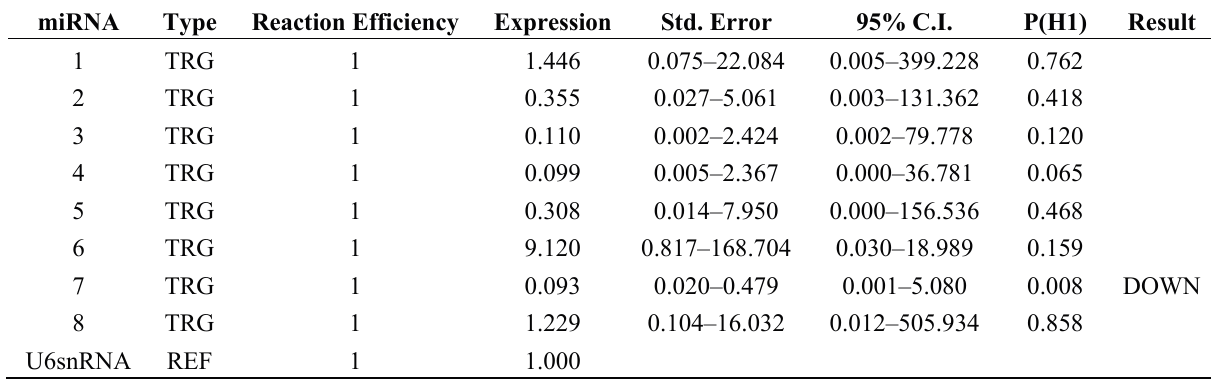
Figure 2. Relative expression (concentration) of the miRNAs analyzed in this study in samples collected in 2010 and frozen at − 80 °C compared with fresh samples. 1 = miR-125b-5p; 2 = miR-425-5p; 3 = miR-200b-5p; 4 = miR-200c-3p; 5 = miR-579-3p; 6 = miR-212-3p; 7 = miR-126-3p; 8 = miR-21-5p. Table 3. Relative expression (concentration), standard error, 95% confidence interval (C.I.), and p -value of miRNAs analyzed in this study (samples collected in 2009 and stored at − 80 °C compared with fresh samples). miRNA 126b-5p ( # 7) decreased significantly ( p = 0.021) while all other miRNAs show no significant